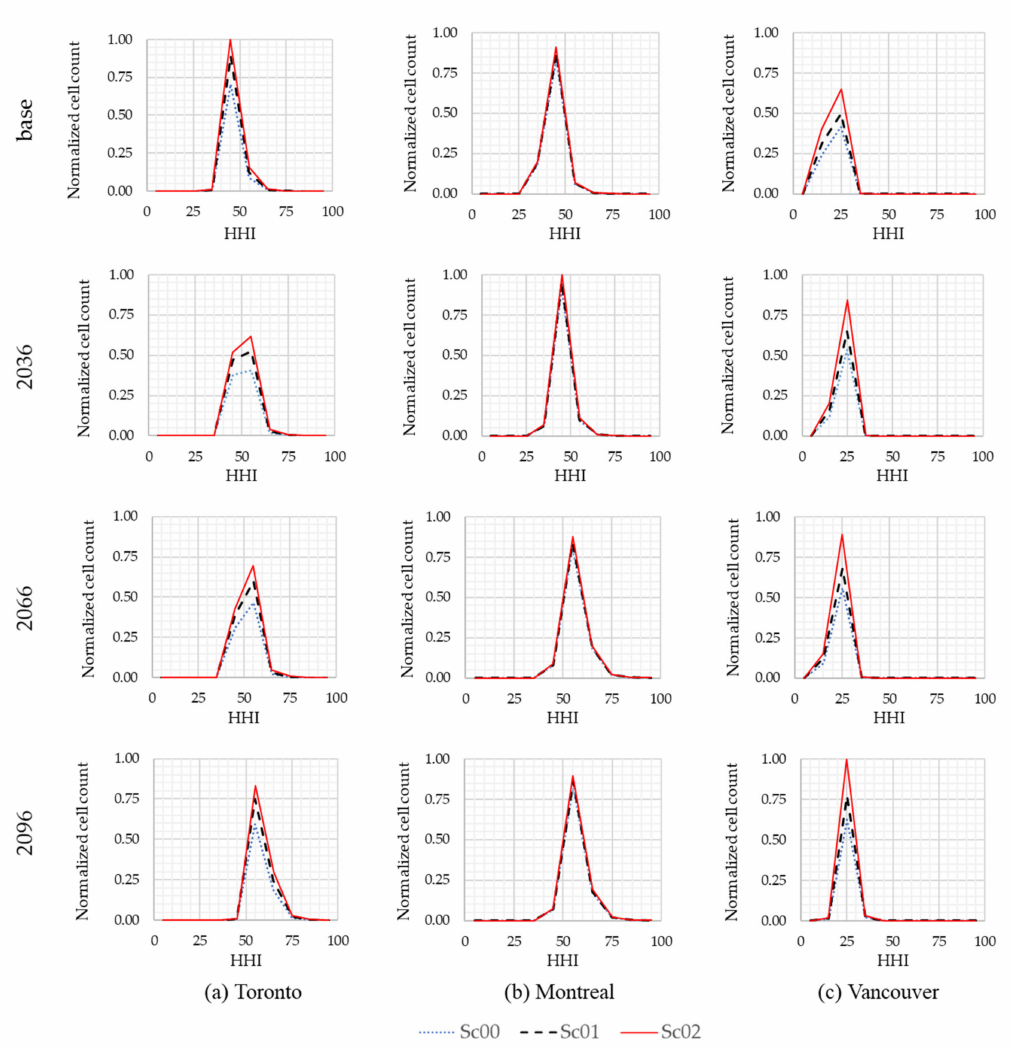
Figure 9. Normalized histograms of HHI (to the maximum HHI frequency of the cities) comparing the same climate scenarios (base, 2036, 2066, and 2096) and di ff erent urbanization scenarios (base, Scenario 1, and Scenario 2) for: ( a ) Toronto; ( b ) Montreal; and ( c )